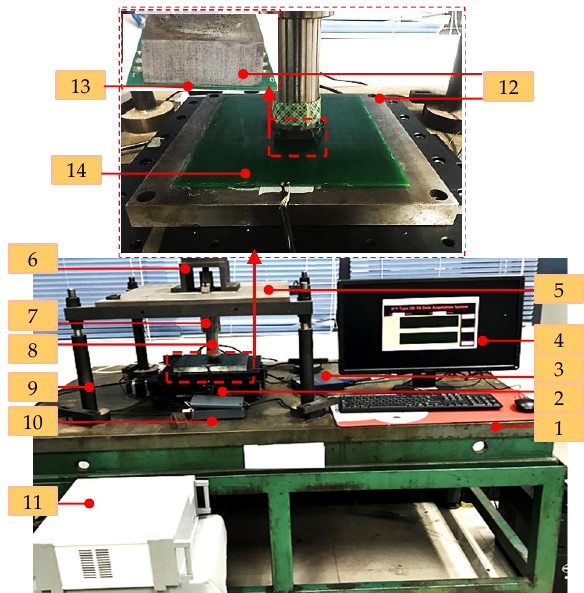
Figure 10. Experimental setup. 1 .base plate; 2 .2D precision positioning stage; 3 .NI data acquisition system (DAQ); 4 .display interface; 5 .upper baseplate; 6 .upper stem; 7 .linear bearing; 8 .feed rod; 9 .steelstems; 10 .exciting circuit; 11 .control box of the stage; 12 .ferromagnetic plate; 13 .secondary coil; 00.511.522.53 （ i / e e o